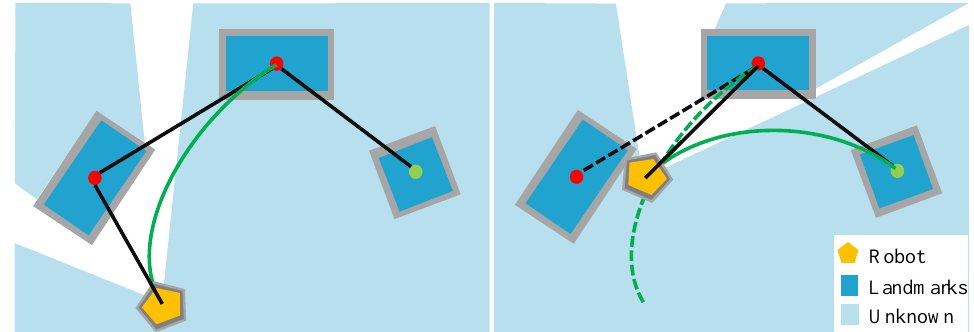
Figure 10. Illustrates of the object-guided topological trajectory generation and refinement.